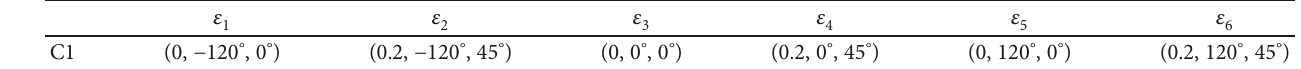
Table 5: C1changed scheme of sensor placement.